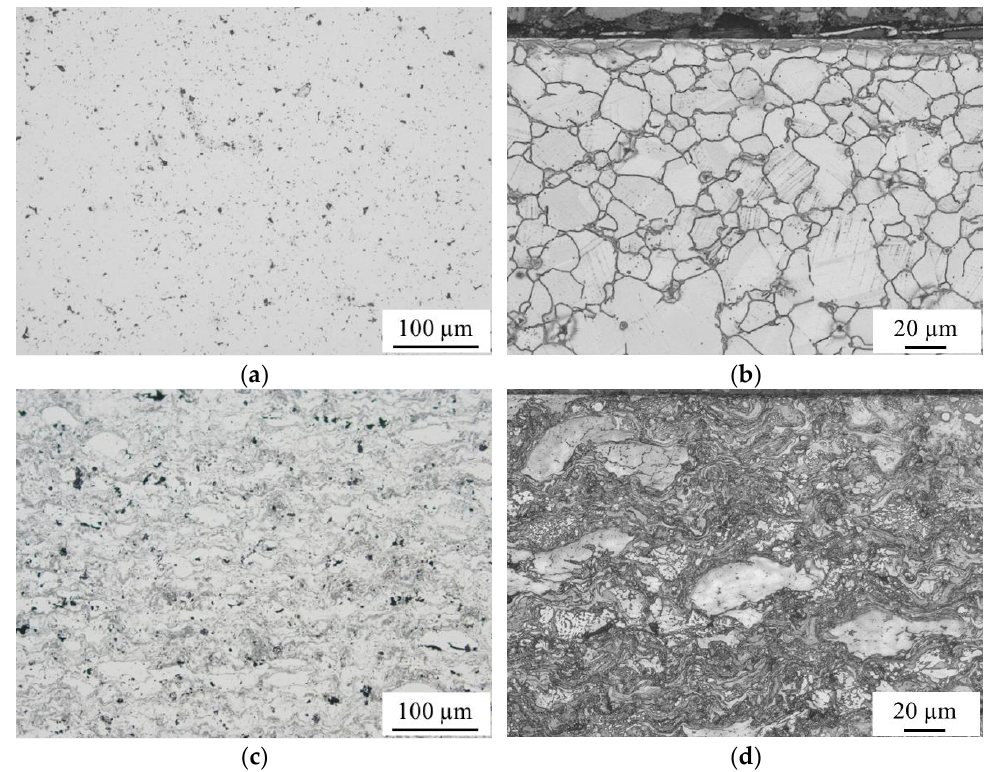
Figure 2. Optical-microscopic image of X120Mn12 ( a ) SPS, ( b ) SPS diamond smoothed and etched, ( c ) HVOF and ( d ) HVOF diamond smoothed and etched cross-sections.